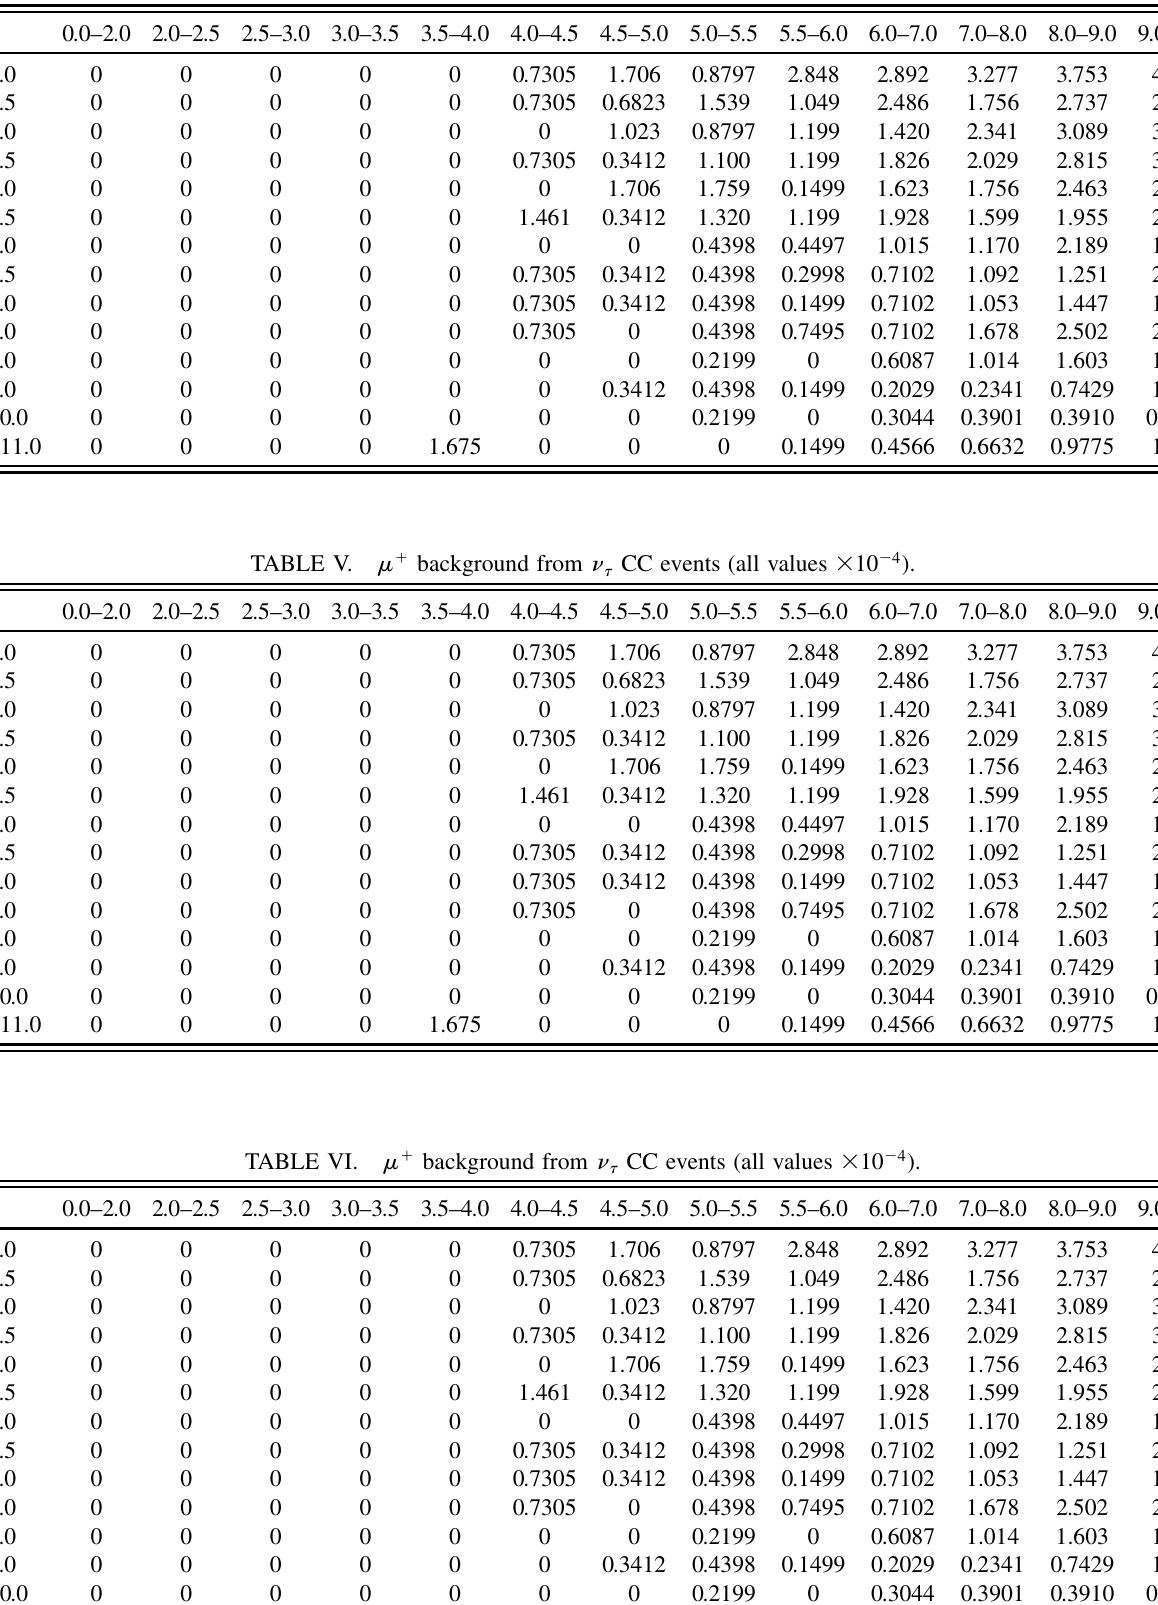
TABLE IV. (cid:4) þ background from (cid:3) (cid:5) CC events (all values (cid:2) 10 (cid:1) 4 ).